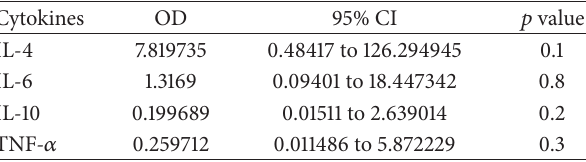
Table 2: Multivariate analysis of proinflammatory and anti- inflammatory cytokines and clinicopathological features of poor prognosis with regard to an increased risk of death.